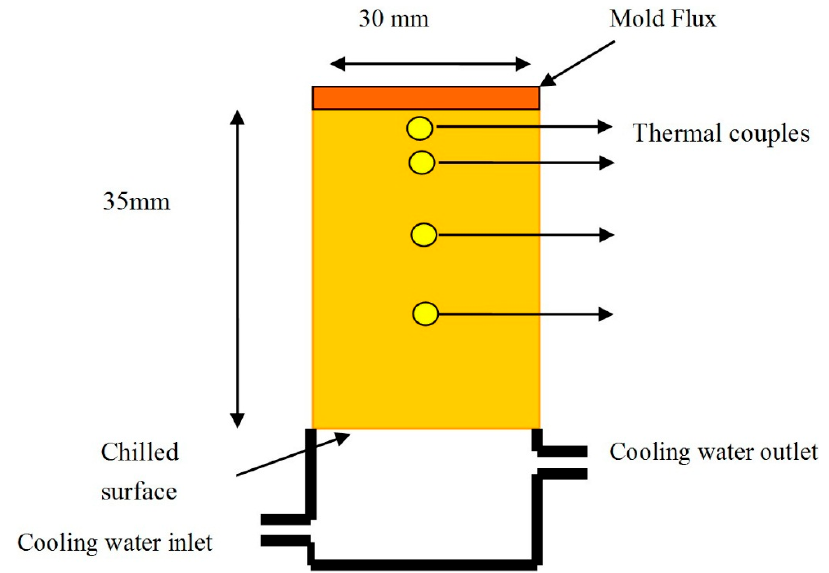
Figure 3. Schematic figure of copper substrate used as the radiation target.